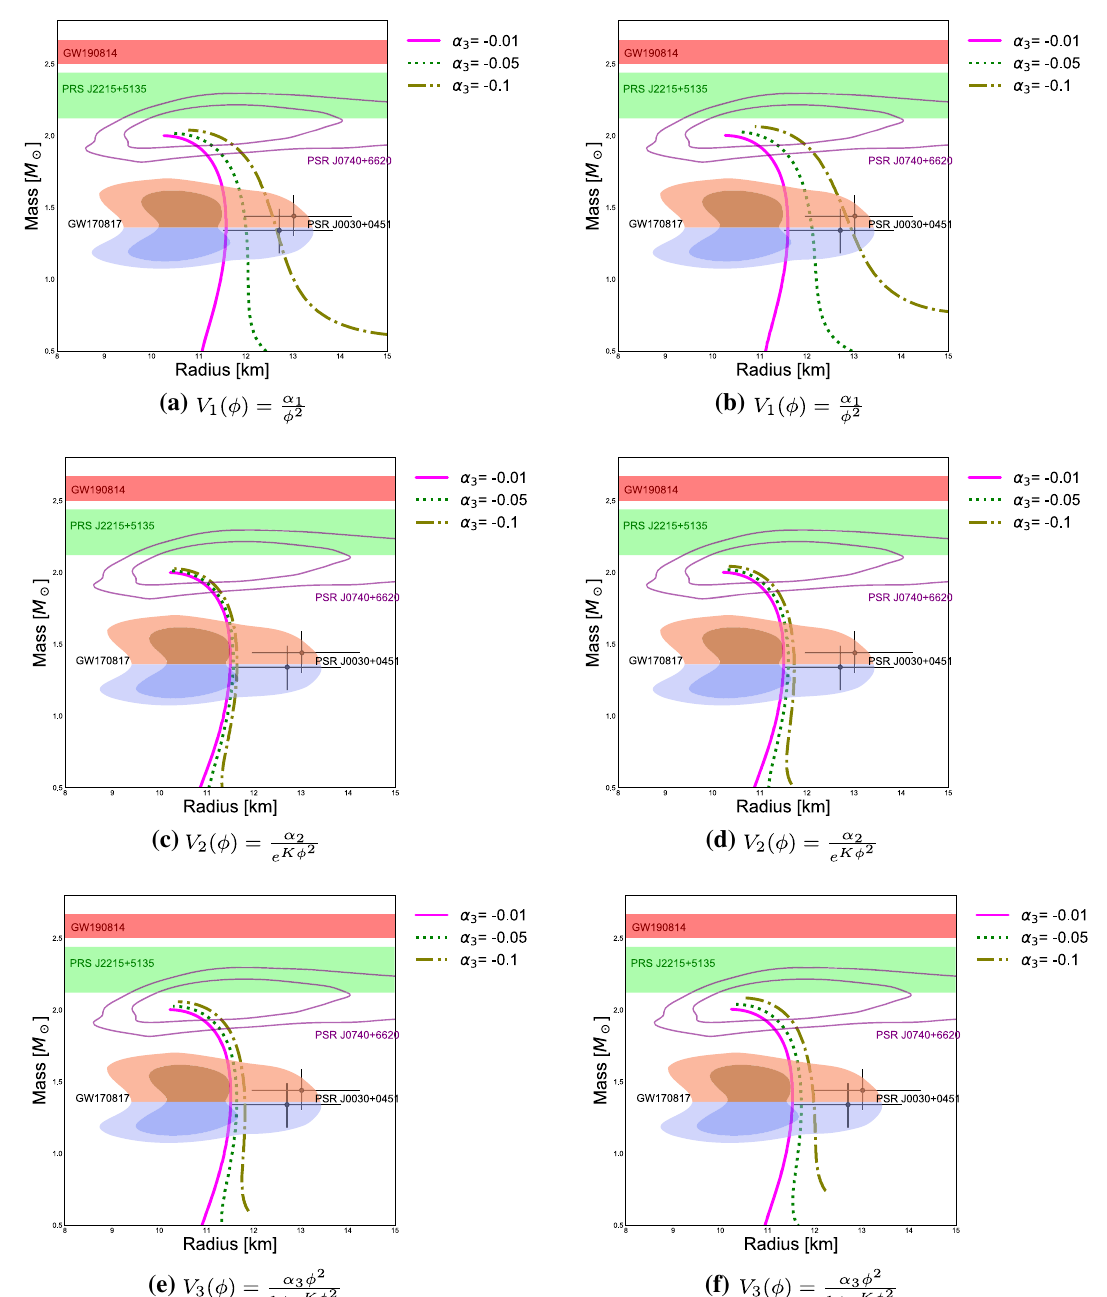
Fig. 9 The mass–radius relation of neutron stars in mimetic gravity for SFHoY EoS. φ( 0 ) = 1: left panels and φ( 0 ) = 0 . 8: right panels and K = 0 .